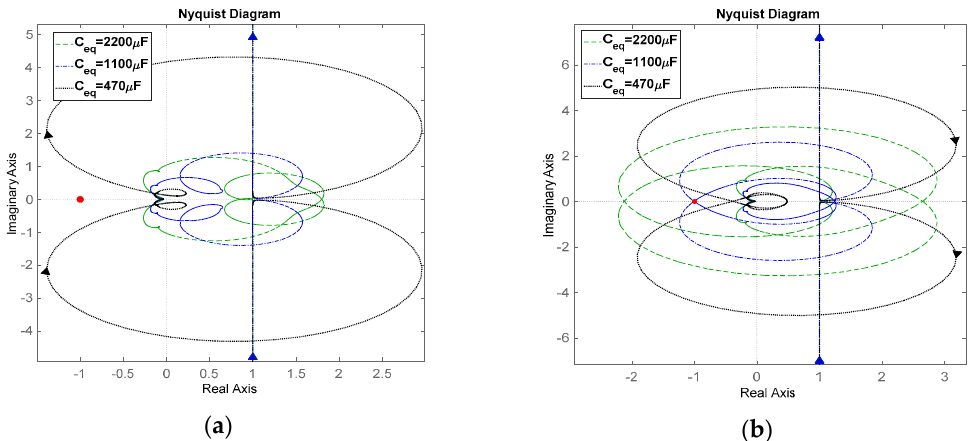
Figure 14. Comparative stability analysis result of the studied dc microgrid system with CPL-side capacitance perturbations. ( a ) Proposed NDOB-VNI stabilizing strategy controlled system; ( b ) Conventional droop controlled system.